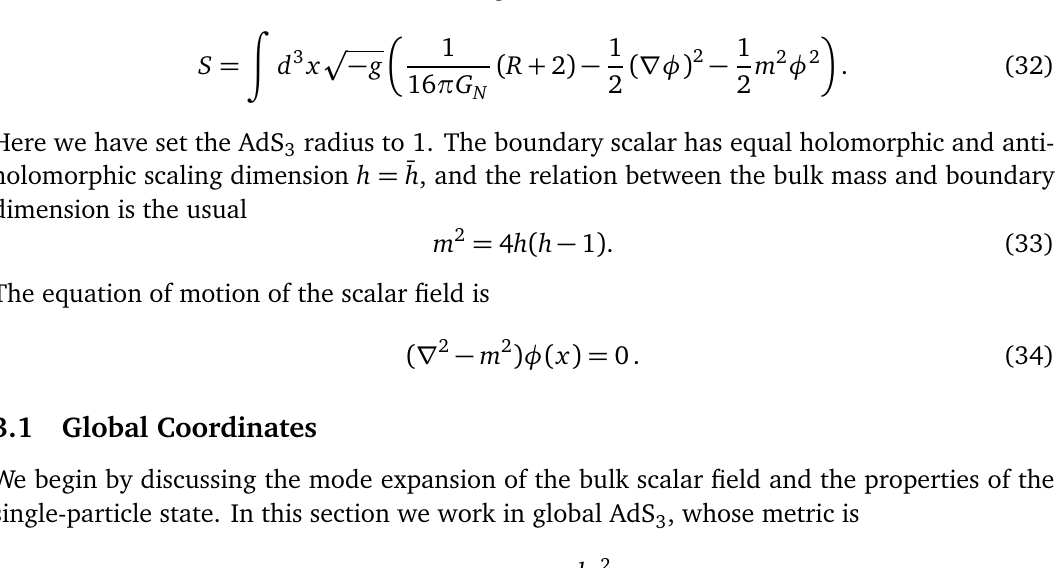
and Σ ¯ , split by the geodesic γ that A A A